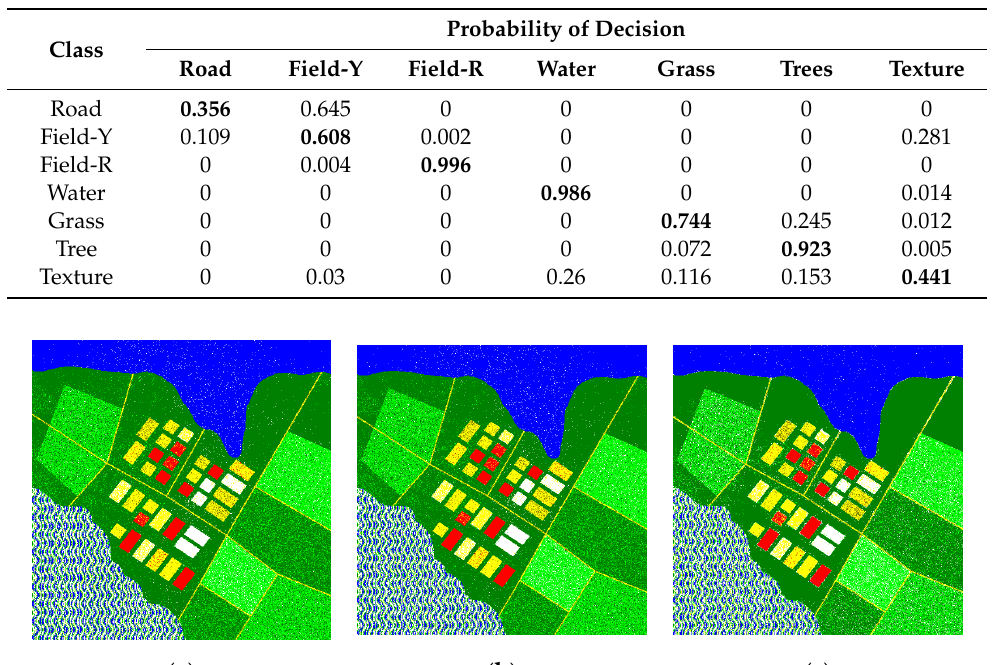
Table 6. Confusion matrix for the original image classified by neural networks (NN) trained for this image.